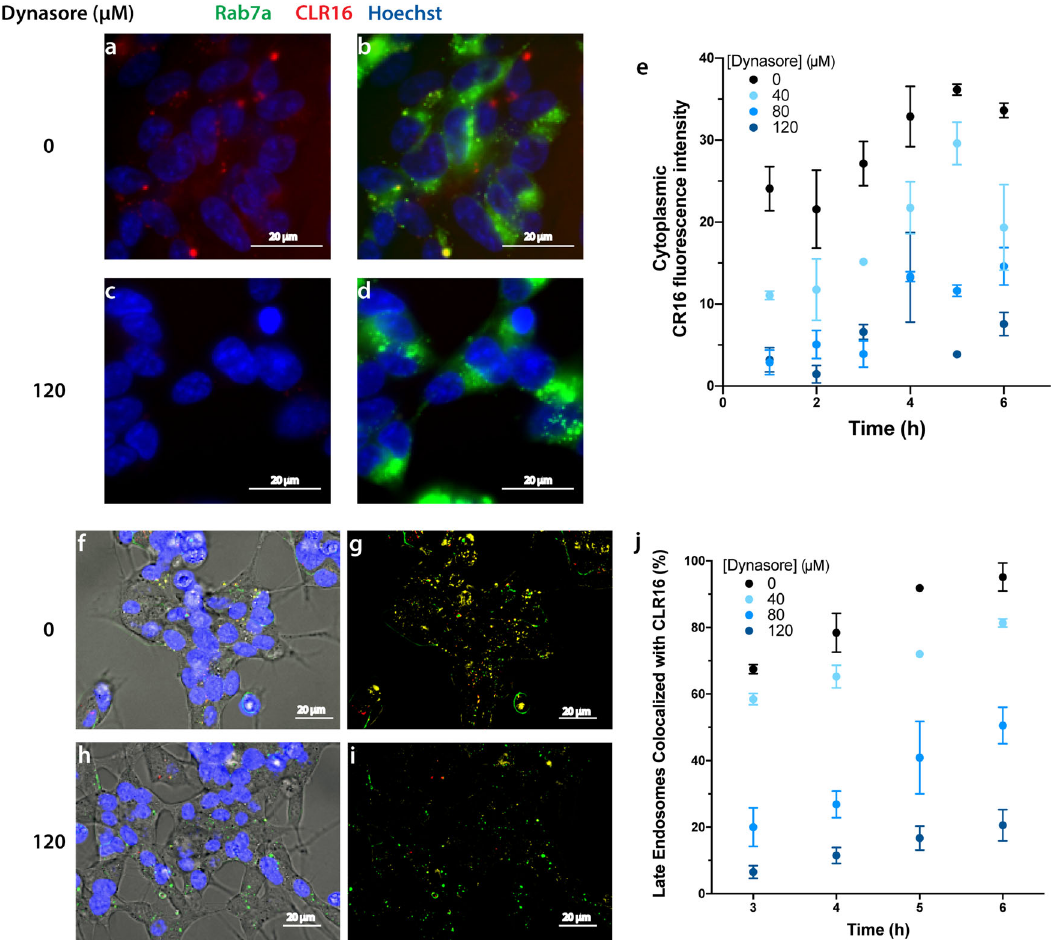
Fig. 5 Dynasore inhibits CLR16 internalization. SH-SY5Y cells were transfected with Rab7a-GFP, and incubated with 5 µ M CLR16 and different concentrations of dynasore. a – d Representative images at t = 5 h after adding CLR16. e Quanti fi cation of the average fl uorescence intensity of CLR16 ( N = 3 arbitrarily chosen fi elds of view in the same experiment). Fluorescent images obtained using haze-reduction settings either overlapping with bright fi eld images ( f , h ) or alone ( g , i ) in the absence ( f , g ) or presence ( h , i ) of 120 μ M dynasore. j Quanti fi cation of the percentage of late endosomes overlapping with CLR16 in all the late endosomes ( N = 3 arbitrarily chosen fi elds of view in the same experiment). The data are presented as mean ±